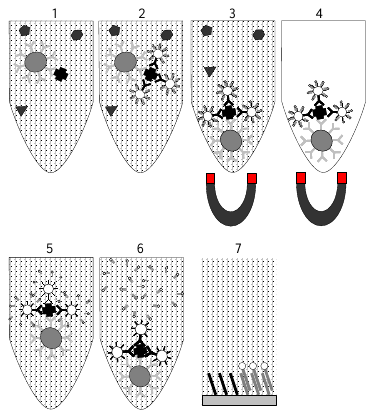
Figure 19. Steps of the bio–bar-code